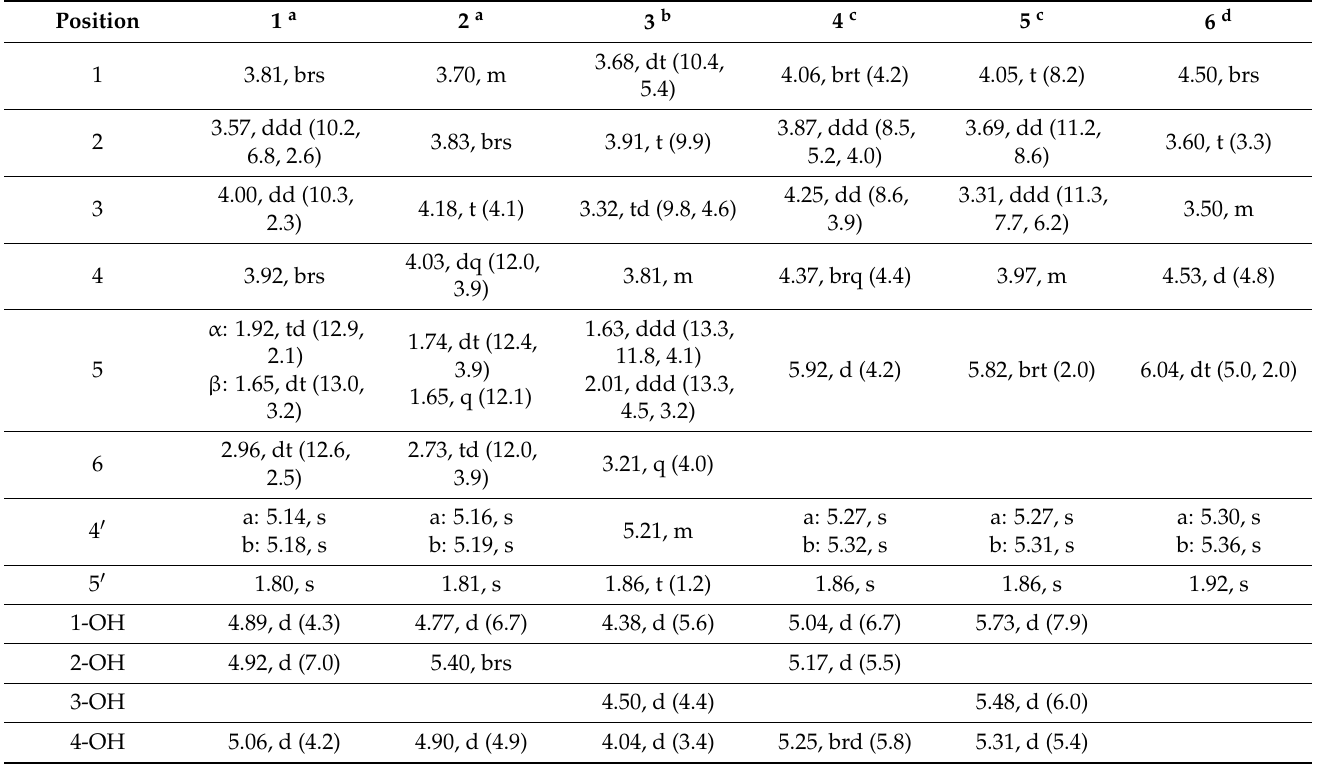
Table 1. 1 H NMR data ( δ in ppm, J in Hz) for compounds ( 1 – 6